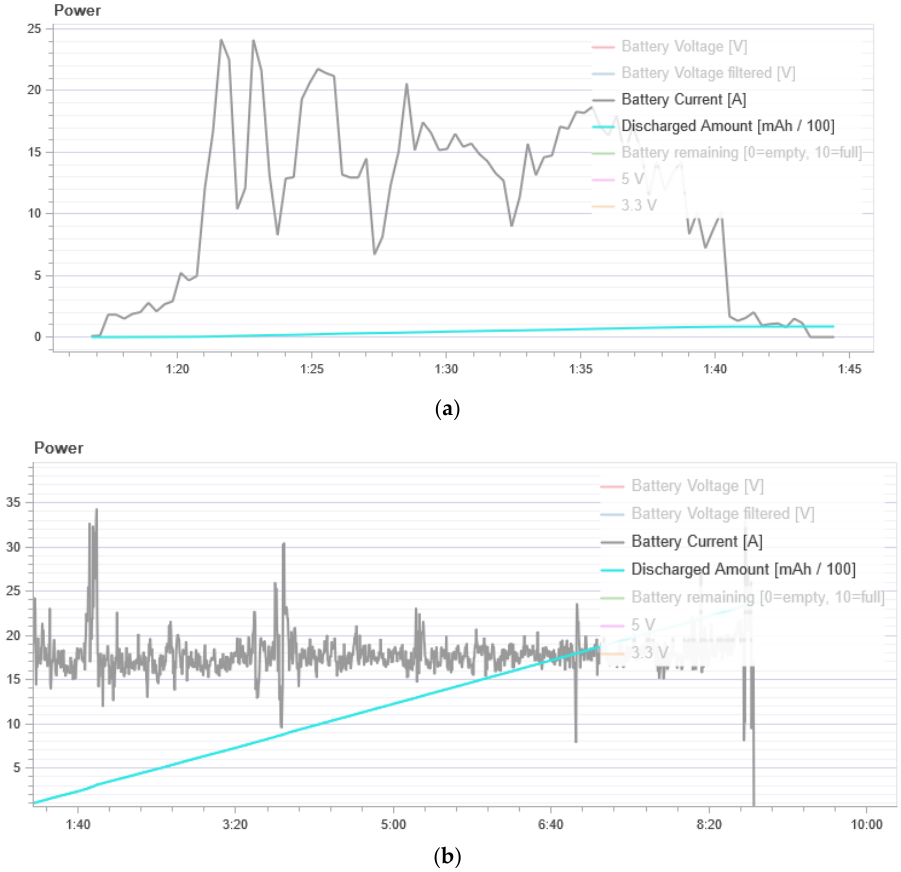
Figure 8. Energy consumption curves: ( a ) In the normal mode; and ( b ) during a GPS attack. Figure 9 shows the measurement result of the condition evaluator. It should be a constant zero. If one of the flags is nonzero, the evaluator has encountered a problem that requires further investigation. In most cases, this is a problem with the sensor, for example, magnetometer interference.